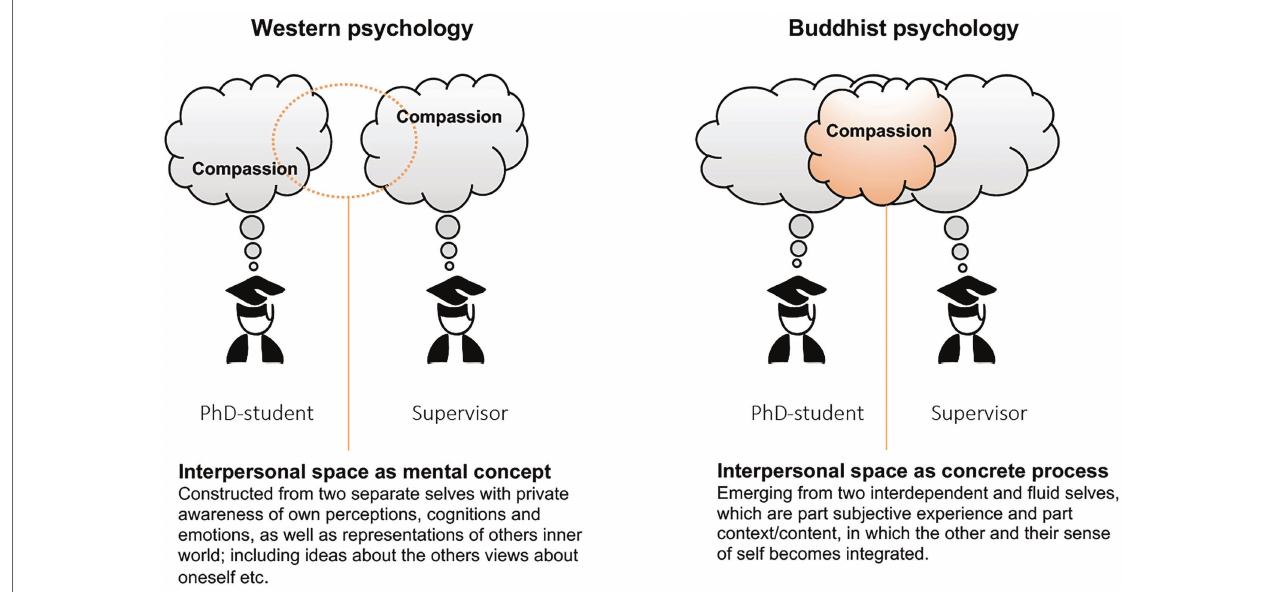
FIGURE 3 | Western- and Buddhist views on the psychology of interpersonal space. Future measurements of e.g., a shared sense of warmth, as fruits of compassionate interactions, will have to address differing views of self and